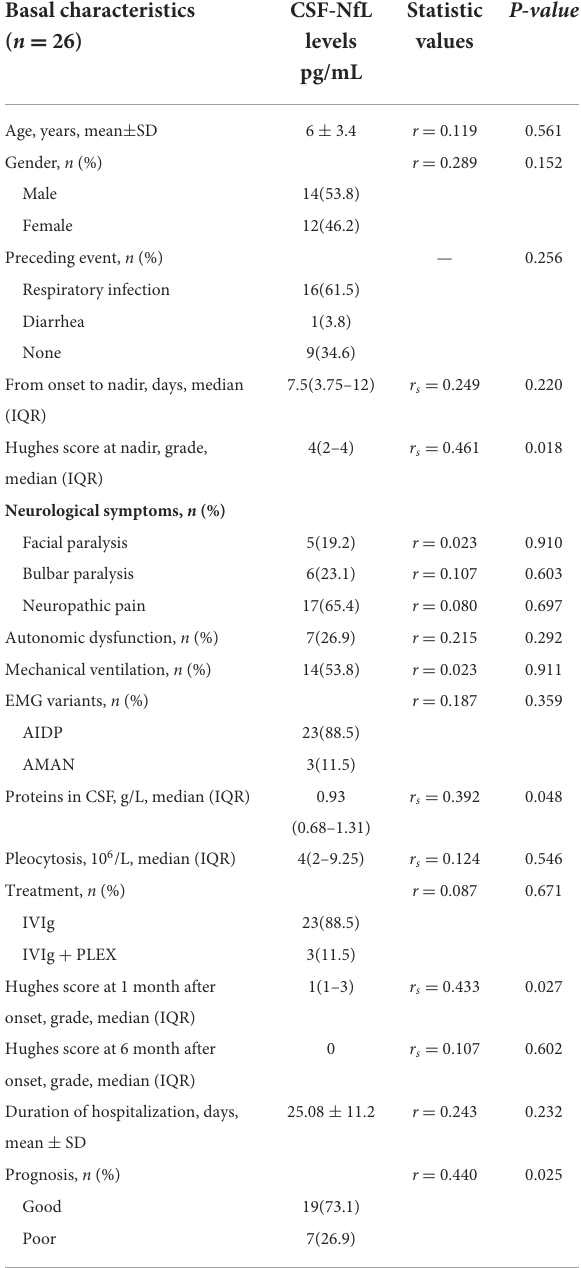
TABLE 2 Relationship between CSF-NfL levels and basal characteristics in pediatric